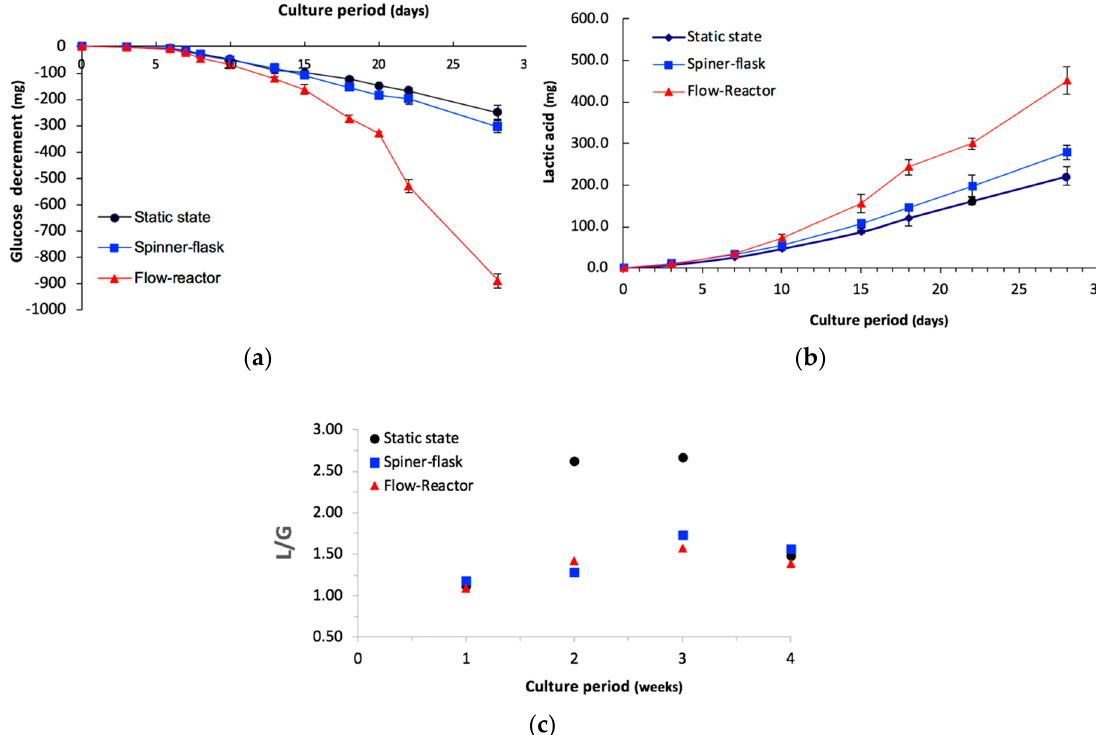
Figure 2. The profiles of ( a ) glucose consumption and ( b ) lactic acid production in culture media from three culture systems. ( c ) Variations in the lactic acid to glucose (Lac / Glu) mole ratio during the culture period. The static-state culture had a high L / G (Lac / Glu) ratio as represented by the anaerobic metabolism, with O 2 shortage occurring during cultivation. However, the low Lac / Glu ratio in the flow reactor and spinner flask revealed that the dynamic culture had high amounts of oxygen and mass transportation.